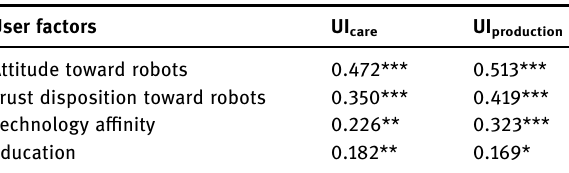
Table 3: Spearman - Rho correlation coe ffi cients for user factors and use intention ( UI ) of care and production robots ( * < p 0.05 , ** < p 0.01 , *** < p 0.001